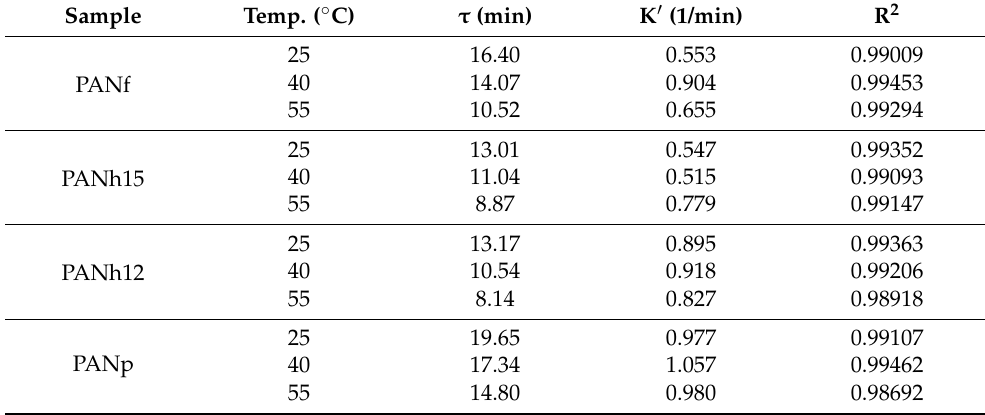
Figure 9. Adsorption breakthrough curves of CO 2 at different temperatures on the samples: ( a ) PANf; ( b ) PANh15; ( c ) PANh12; ( d ) PANp. The lines are the fitted results using the Yoon and Nelson equation. Table 4. Fitted parameters of the Yoon and Nelson equation for the CO 2 adsorption breakthrough data on the samples at different